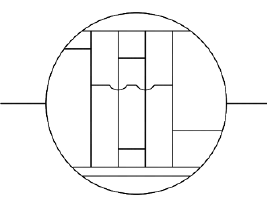
Figure 12. General self-energy